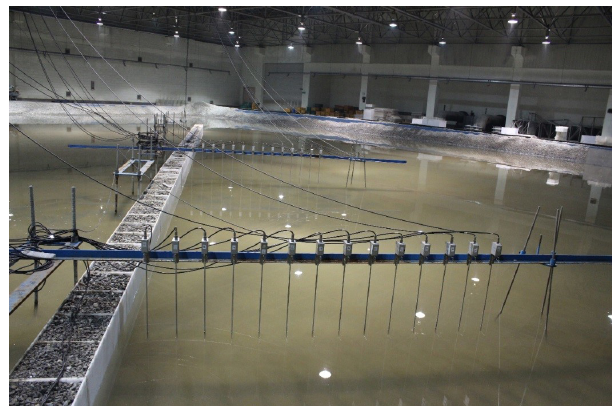
Figure 3. Experimental facility and wave gauge